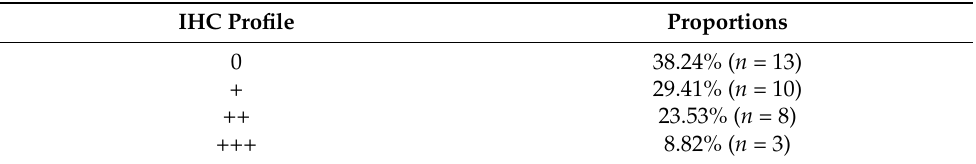
Table 7. Proportions of HER2 protein immunohistochemistry expression.